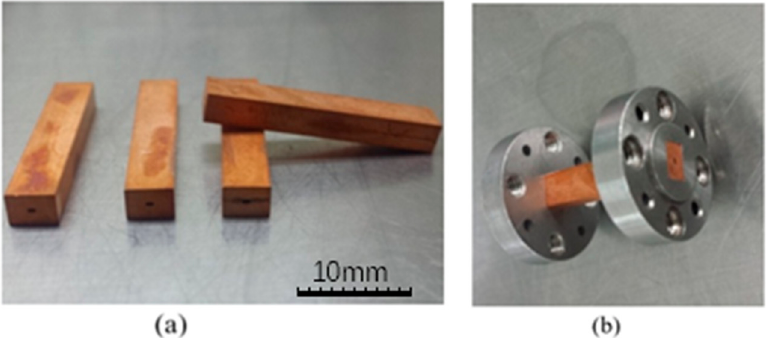
Figure 10. ( a ) Complete copper terahertz straight waveguide structures consisting of a channel block and a cover after bonding. ( b ) Cross-section of the waveguide structure.